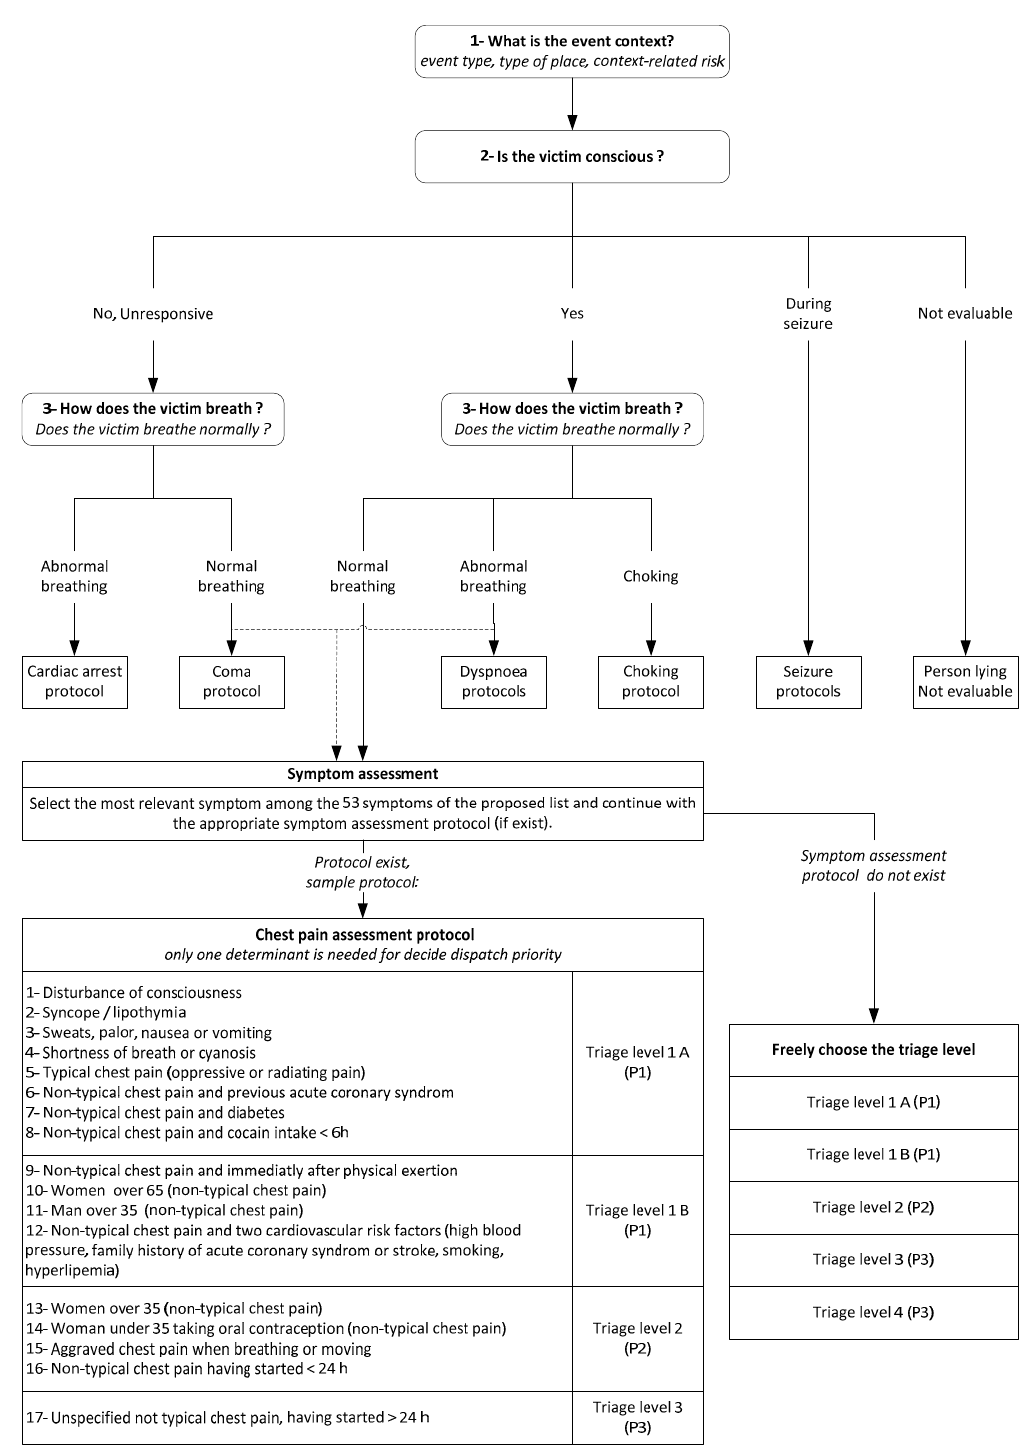
Figure 1. Principles of the symptom-based dispatch system.